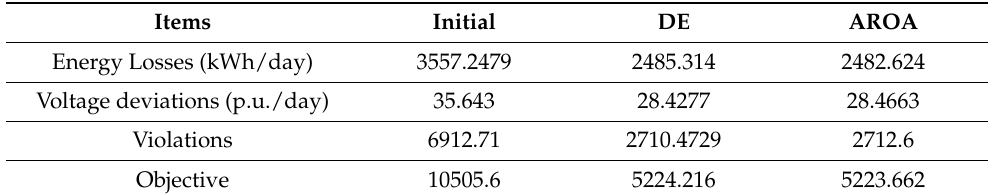
Table 1. Allocations of PV without STATCOM for the second scenario for the IEEE 33-distribution system . Table 2. Corresponding energy losses, voltage deviations, and violations for the second scenario for the IEEE 33-distribution system.